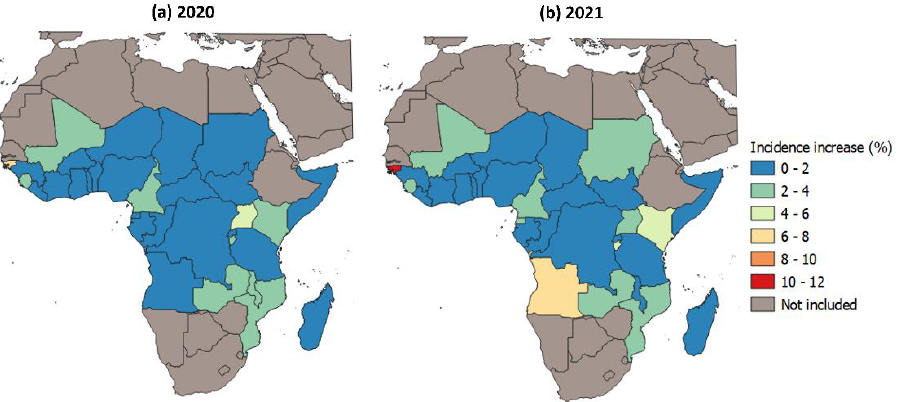
Figure 3. Estimated national level % mean increase in malaria incidence in the study region brought upon by disruptions in malaria case management in ( a ) 2020 and ( b )